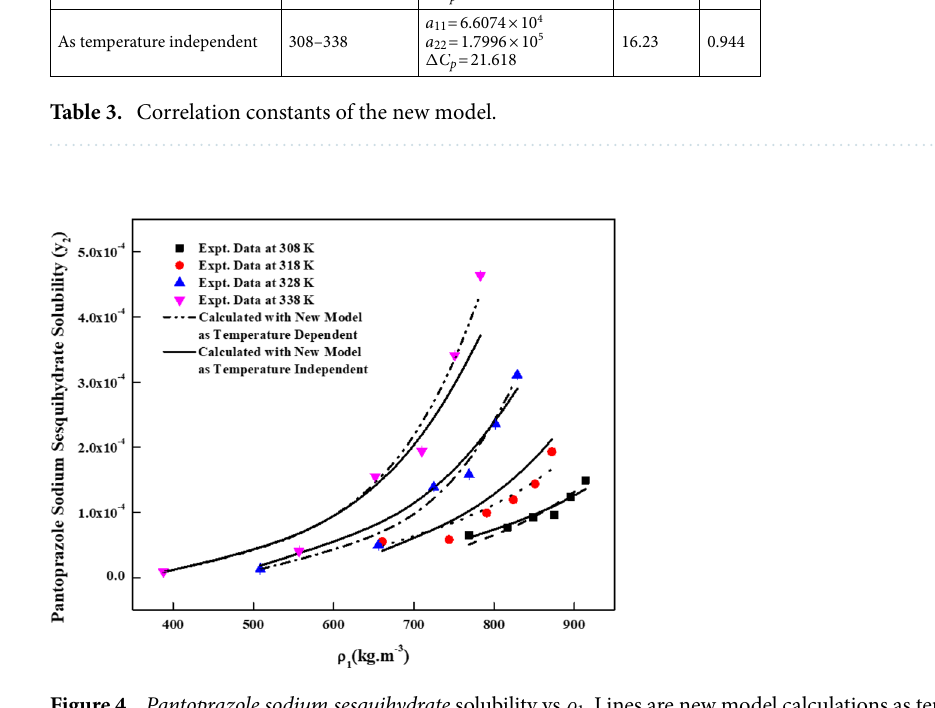
Figure 4. Pantoprazole sodium sesquihydrate solubility vs. ρ 1 . Lines are new model calculations as temperature independent; dash, dot, dash dot and dash dot dot lines are new model calculations as temperature